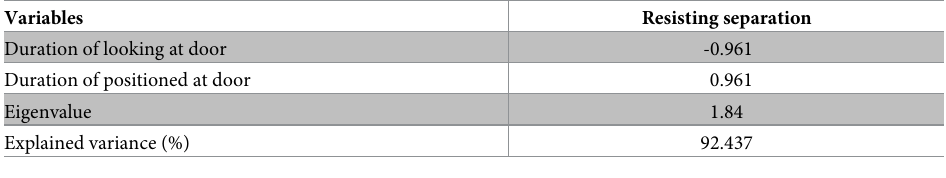
Table 7. Component derived from PCA on the variables measured in the separation